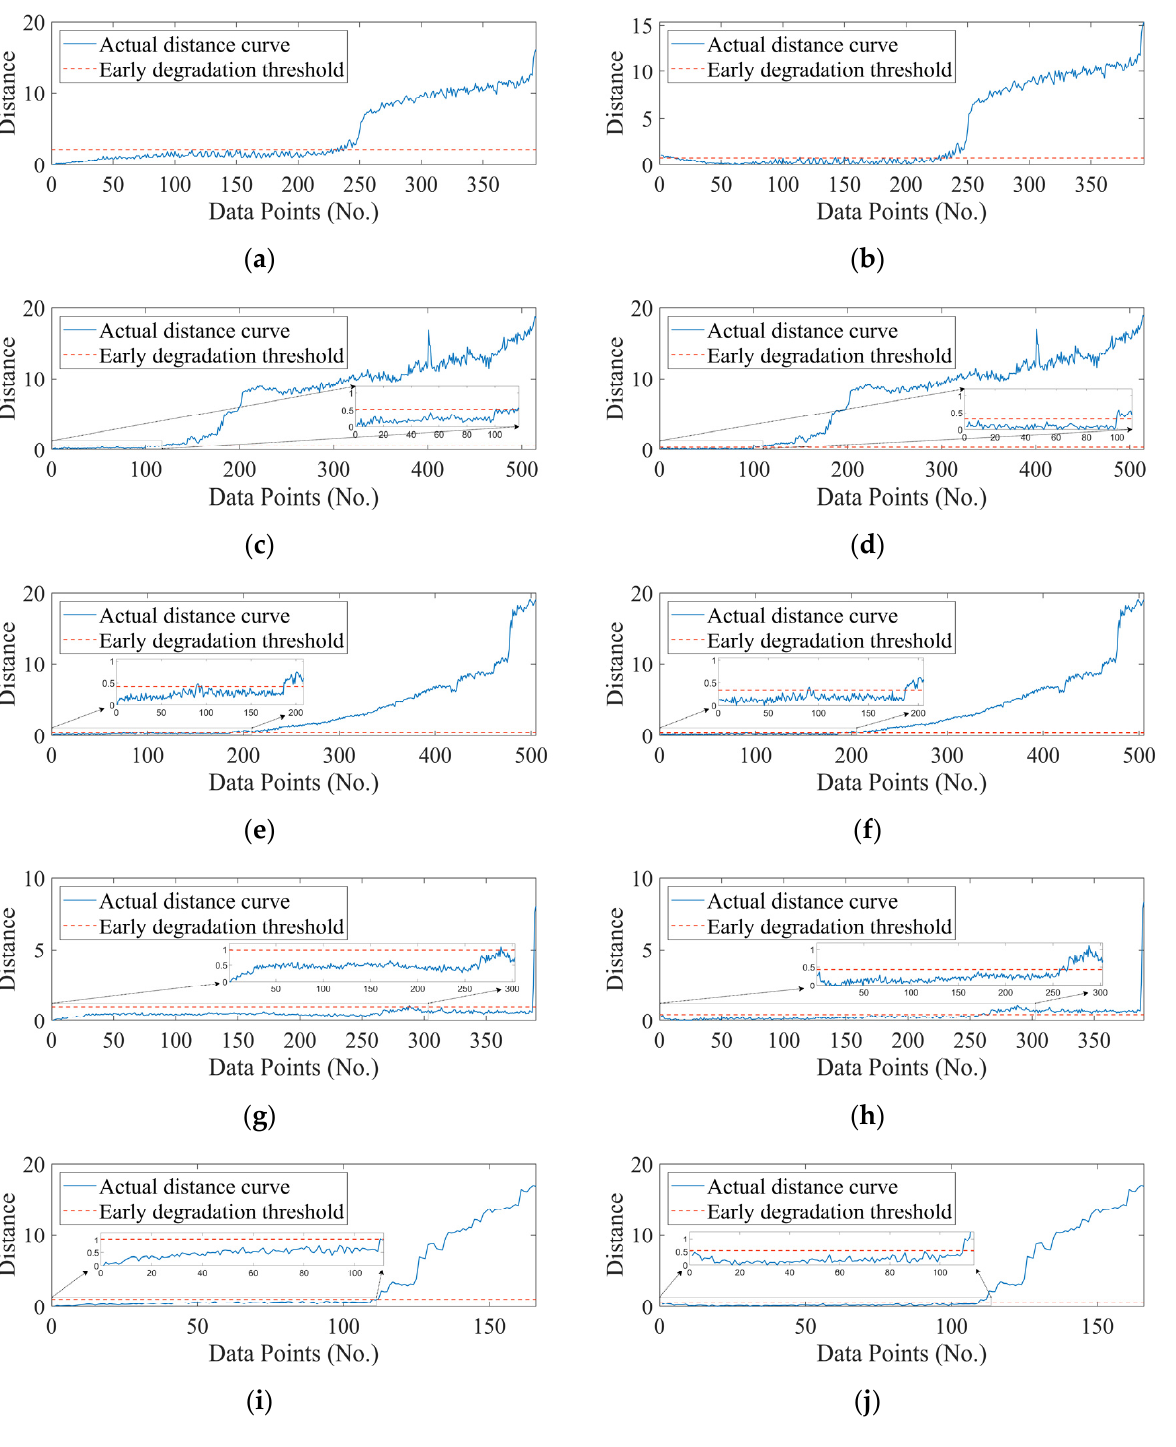
Figure 7. Distance curves based on the first sample: ( a ) Bearing 1_1, ( c ) Bearing 1_2, ( e ) Bearing 1_3, ( g ) Bearing 1_4, ( i ) Bearing 1_5; distance curves based on the OHS sample: ( b ) Bearing 1_1, ( d ) Bearing 1_2, ( f ) Bearing 1_3, ( h ) Bearing 1_4, ( j ) Bearing 1_5.